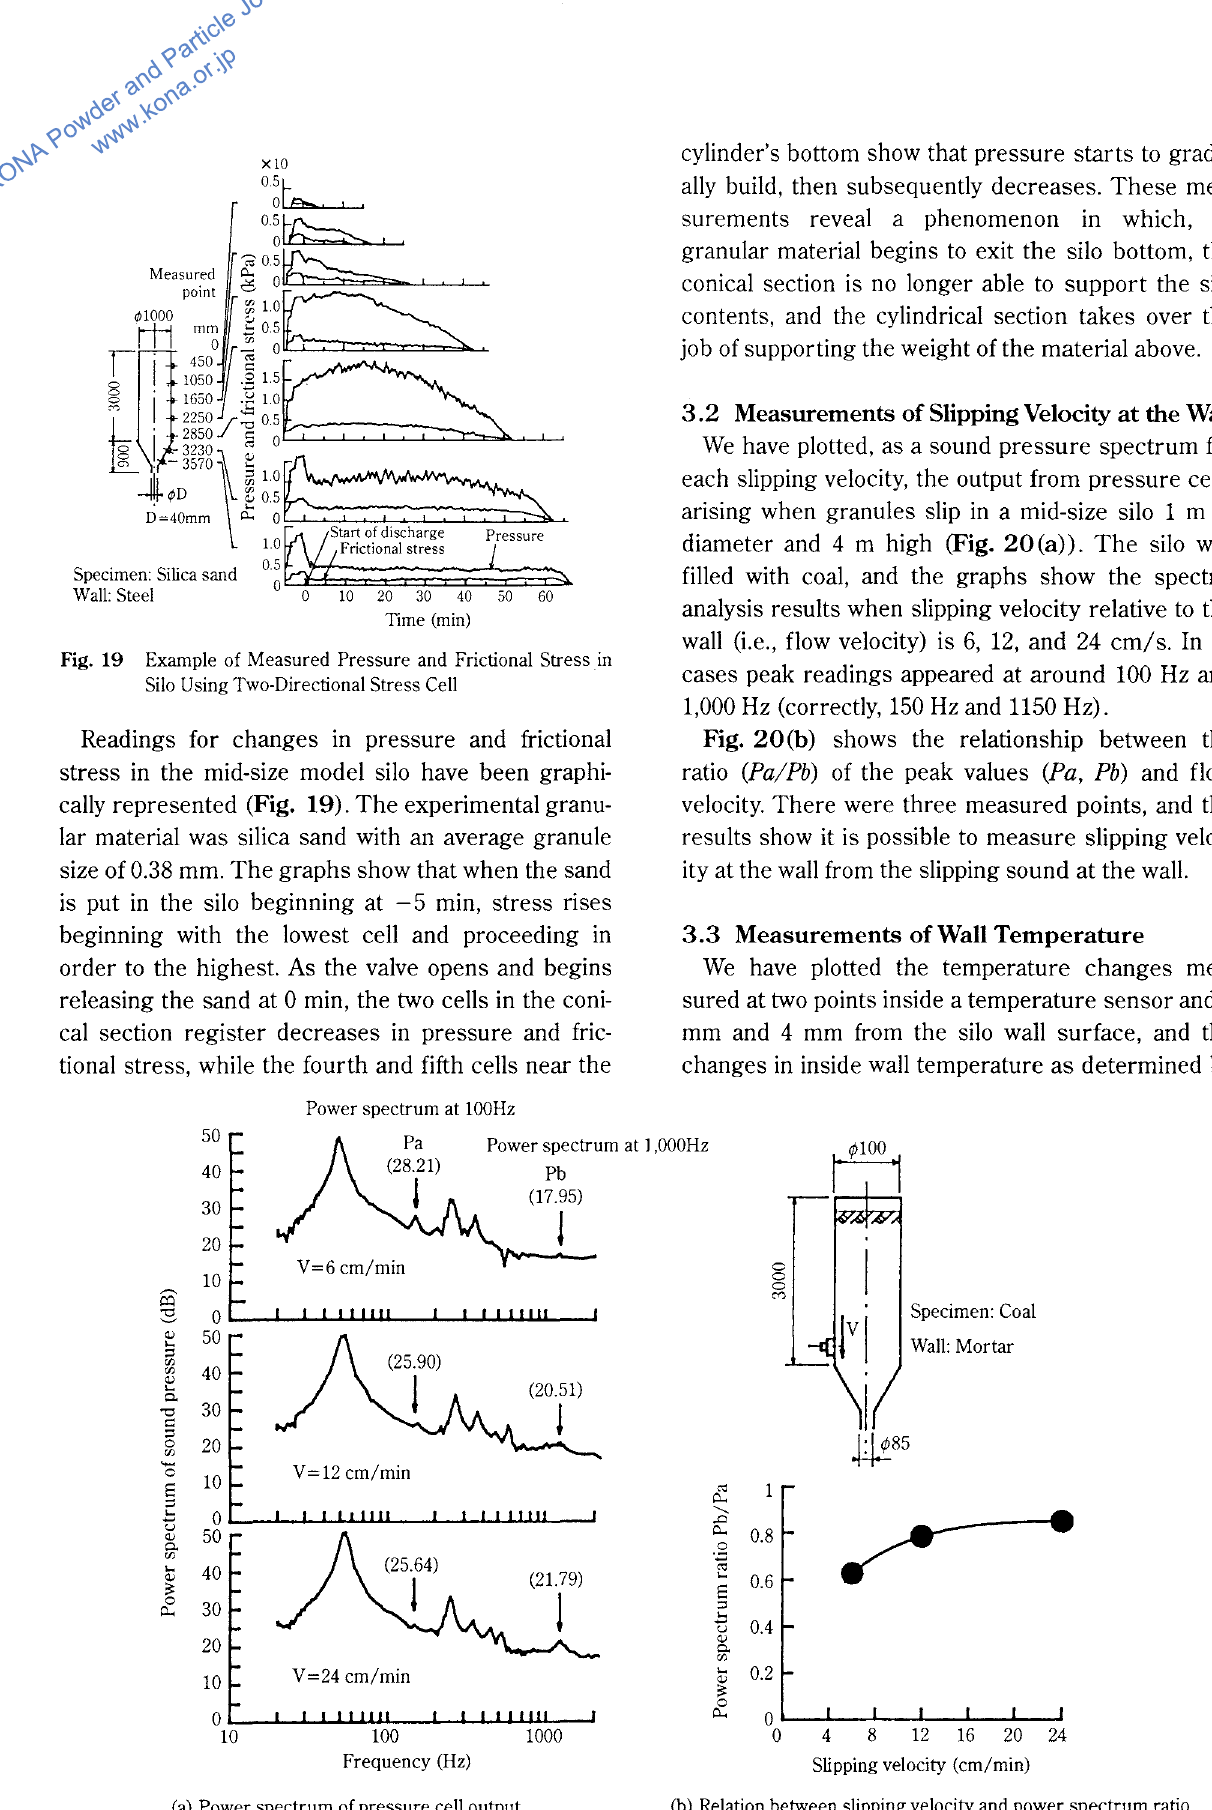
Fig. 20 Example of Measured Power Spectrum of Pressure Cell Output in